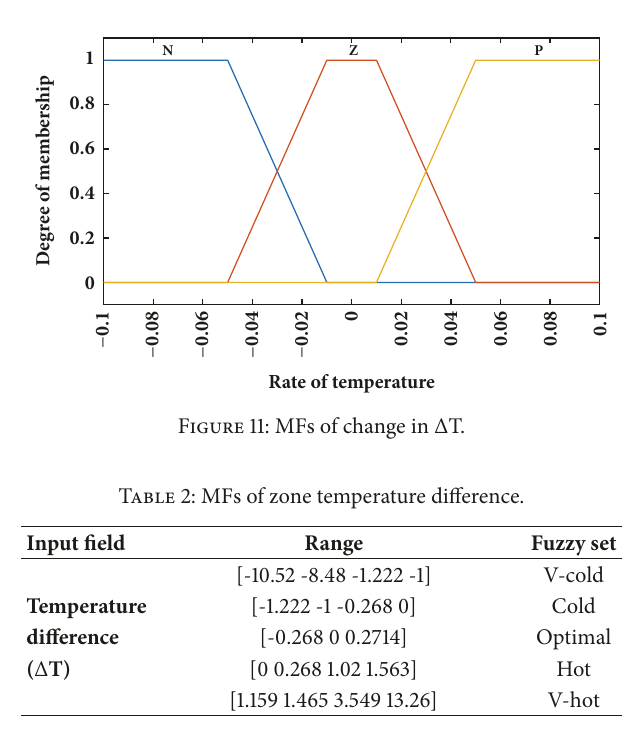
Table 3: MFs of change in Δ T.